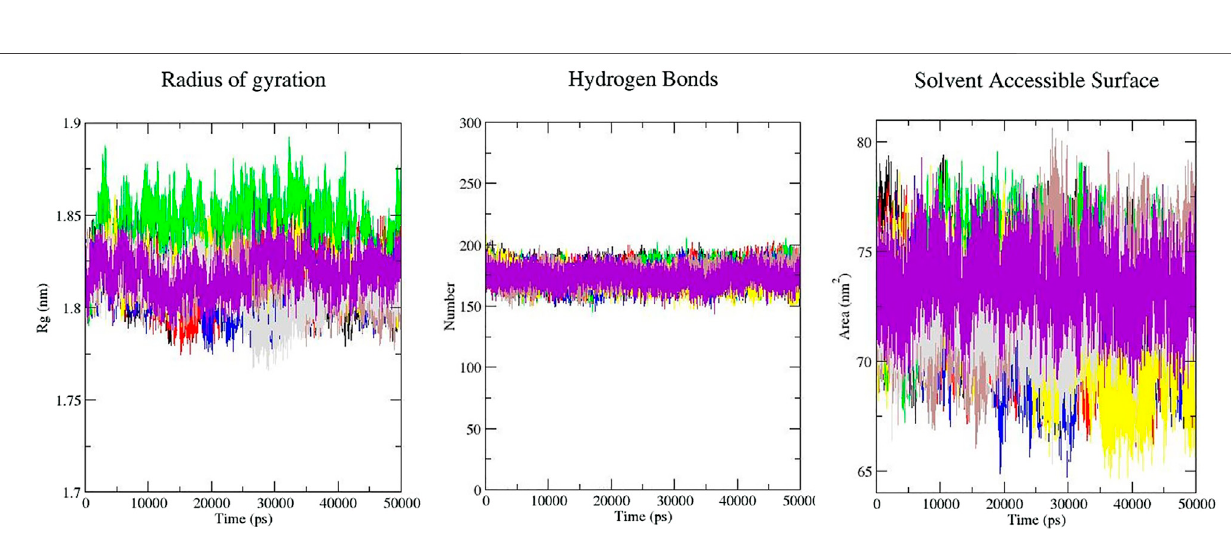
Frontiers in Pharmacology |